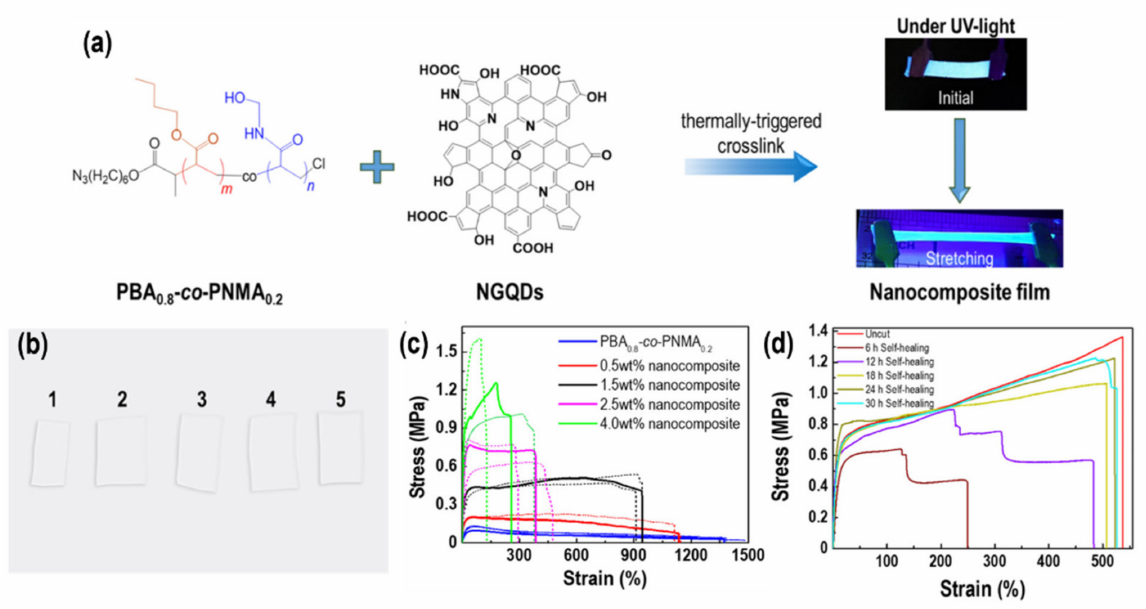
Figure 6. Fabrication of skin-like GQD-based nanocomposite film [81]. ( a ) Preparation of the stretchable NGQDs/PBA 0.8 - co -PNMA 0.2 nanocomposite film. ( b ) Optical transparency of (1) PBA 0.8 - co -PNMA 0.2 film and NGQDs/PBA 0.8 - co -PNMA 0.2 nanocomposite films with (2) 0.5, (3) 1.5, (4) 2.5 and (5) 4.0